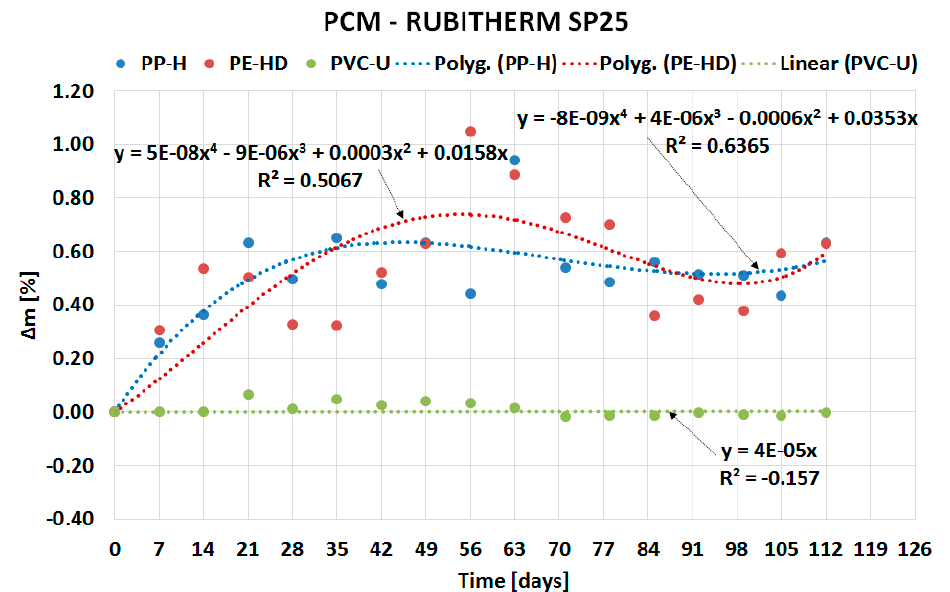
Figure 4. Dependence of mass change of tested plastics on duration of the experiment for SP25.